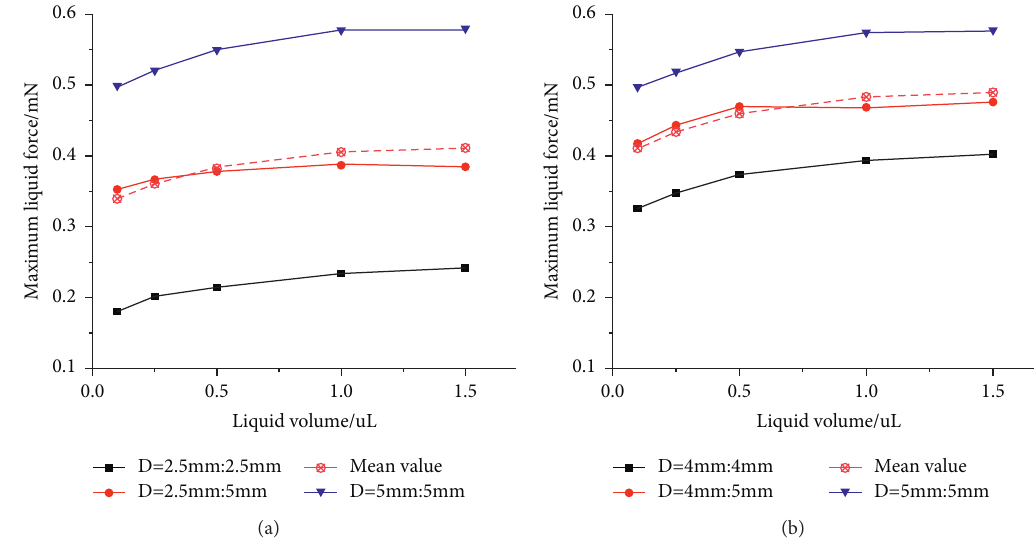
Figure 6: The maximum liquid force-liquid volume curves: (a) the upper sphere equals 2.5mm; (b) the upper sphere equals